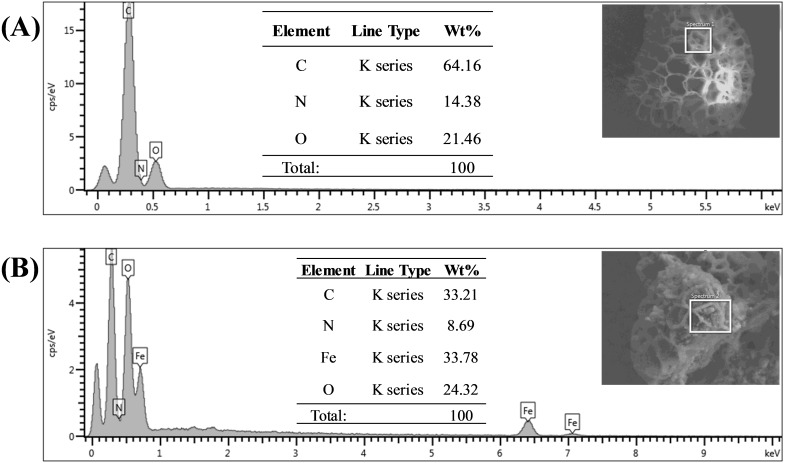
EDX spectra of synthesized adsorbent.EDX spectra of (A) Sp-TDI-calix and (B) MSp-TDI-calix.